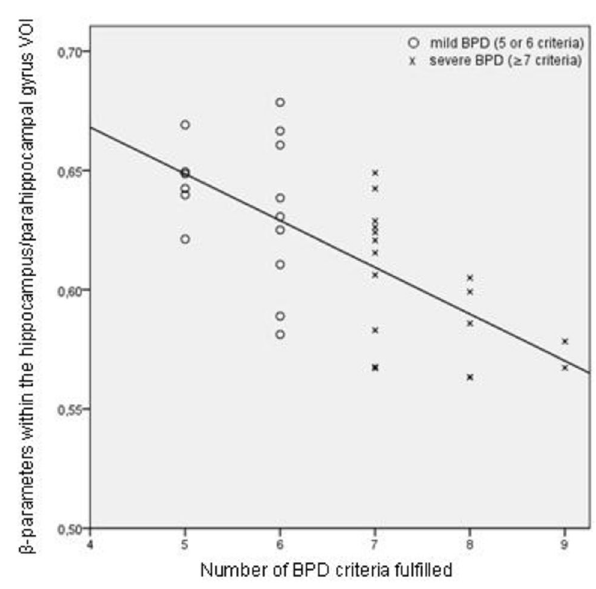
Figure 3. Correlation between hippocampus volume and BPD criteria. Correlation between the volume within left hippocampal region (β-parameters) and the number of BPD criteria